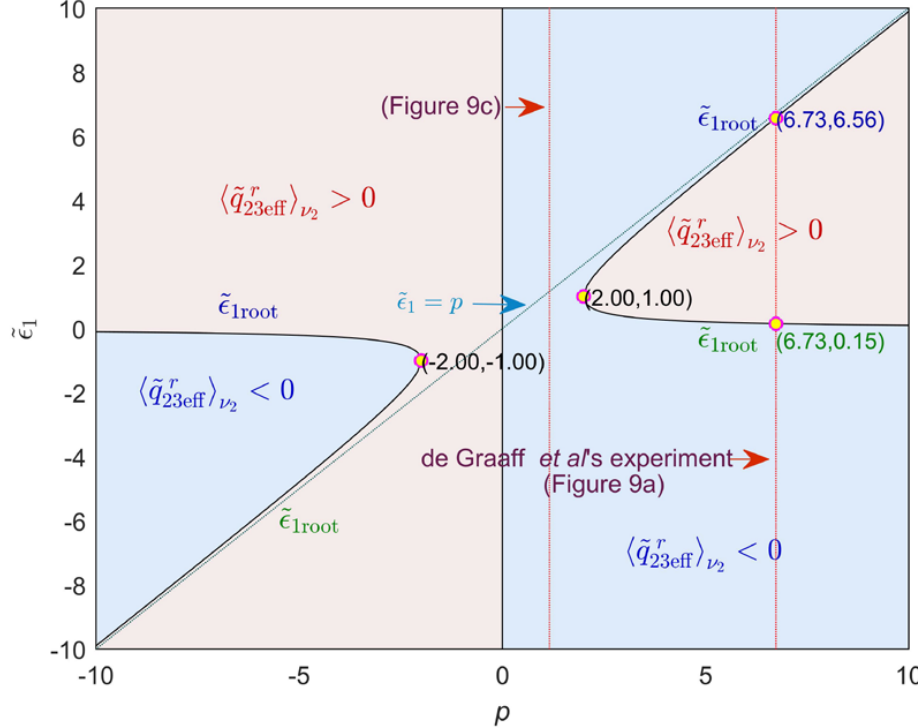
(cid:10) (cid:11) r ( (cid:101) ε ) = 0 for the three-closed-channel system consisting of one acting as (cid:101) q ( ) 1 23eff ε =  for the three-closed-channel system consisting of one ν 2 0 r q 23eff 1 ν 2